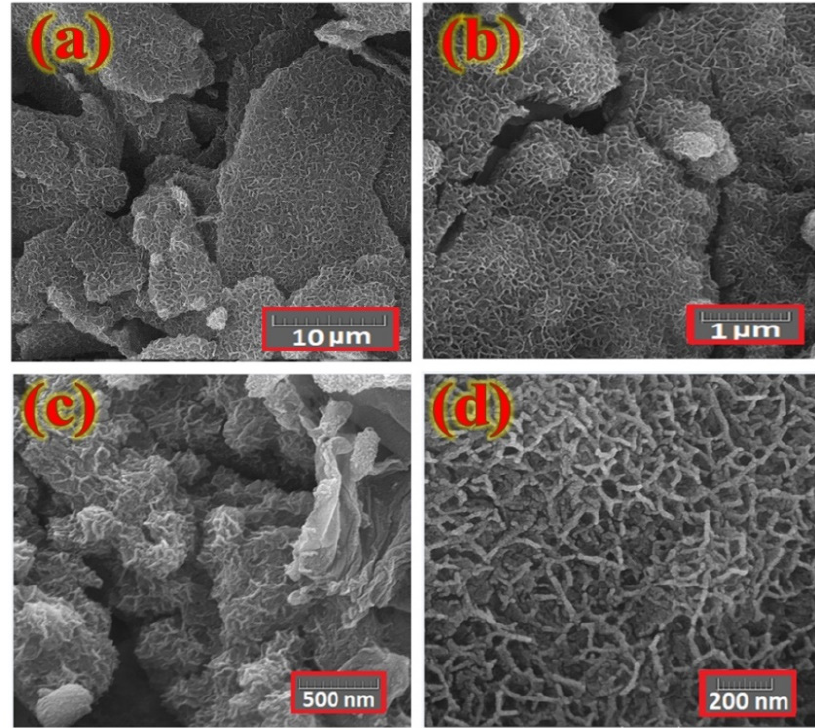
Figure 5. FESEM images of interlaced Co x NiV y O z nanosheets deposited on rGO-coated Ni foam substrate at various magnifications. ( a ) 10 µ m, ( b ) 1 µ m, ( c ) 500 nm, ( d ) 200 nm.